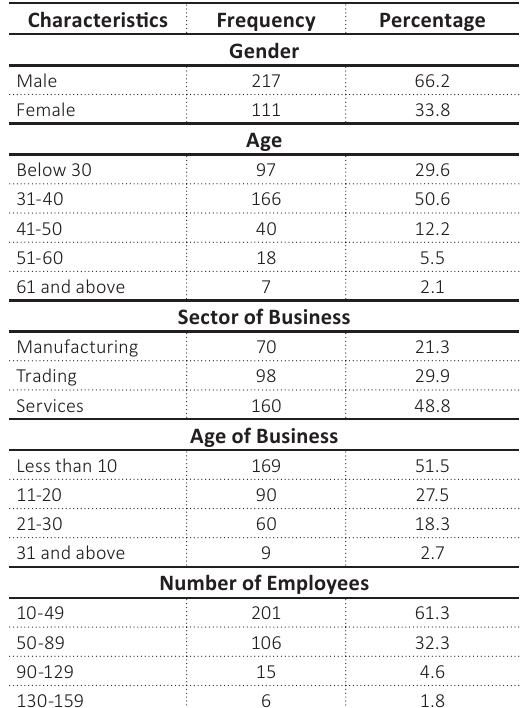
Table 1. Demographic profile of the respondents and business